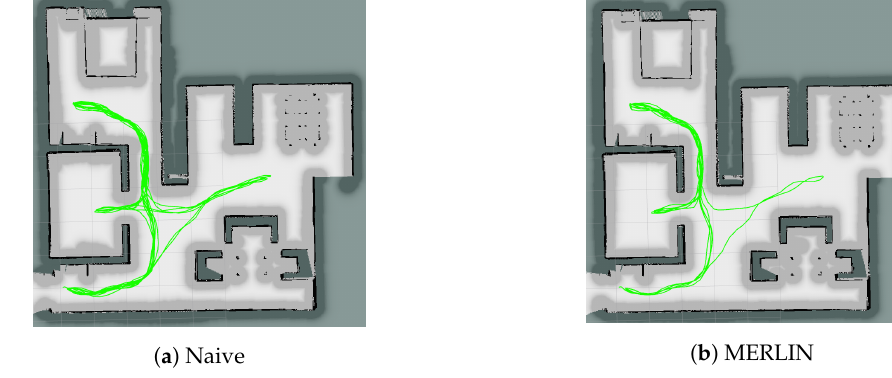
Figure 9. Paths of experimental approach in Mission 2 with 20 PoIs.